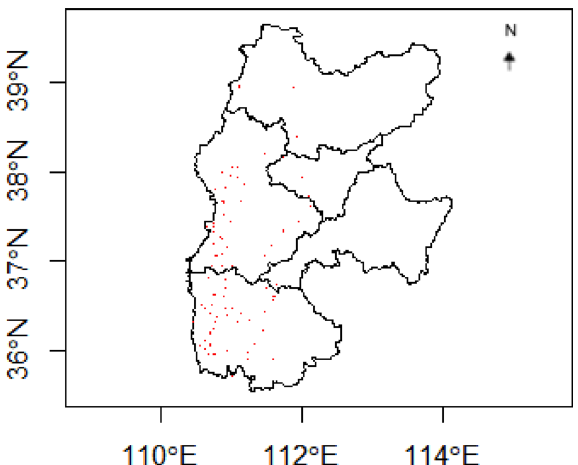
Figure 14. Lv Liang sampling locations mapped on Jin-Shan Loess Plateau (red dots); sketch via R .